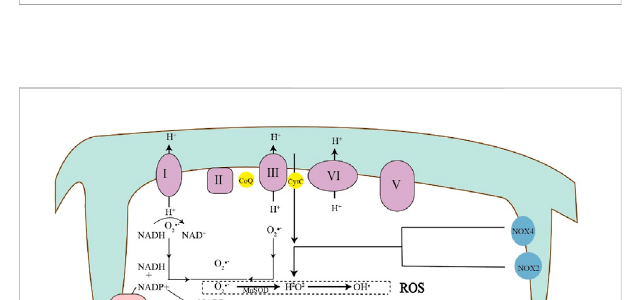
FIGURE 3 The tricarboxylic acid cycle produces NADH, which provides NADH for the electron transport chain and NNT. The electron transport chain can transfer hydrogen ions to the intermembrane space, and the hydrogen ions located in the membrane gap pass through NNT, resulting in antioxidant NADPH.